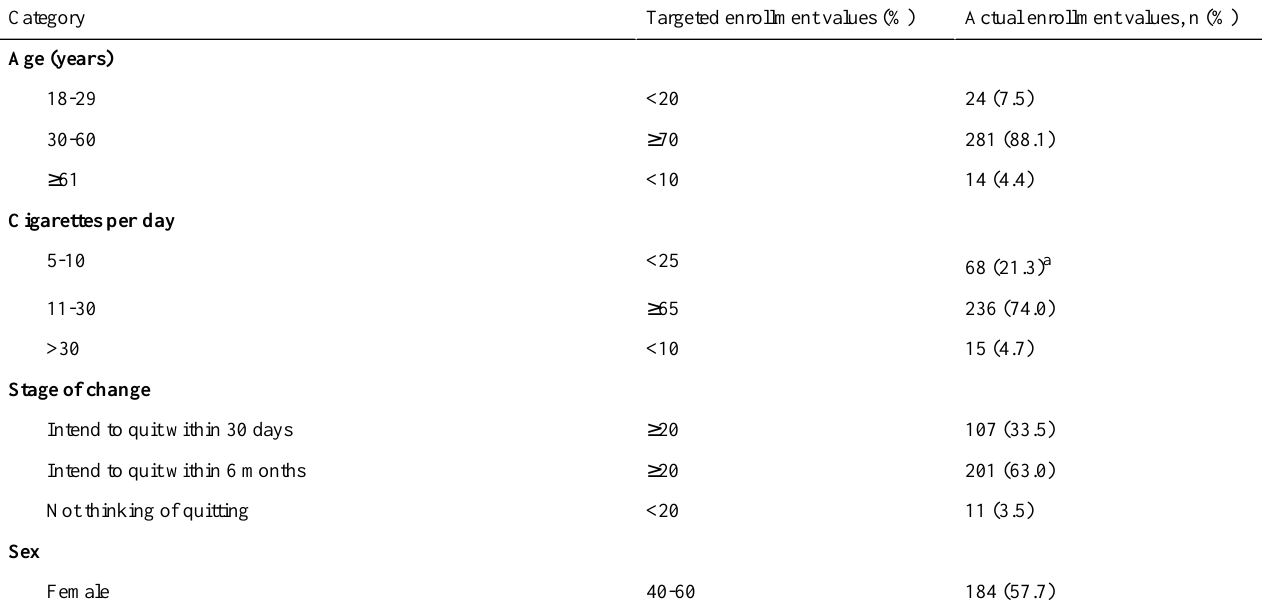
Table 1. Nonproportional quota sampling enrollment: target and actual values (n=319).